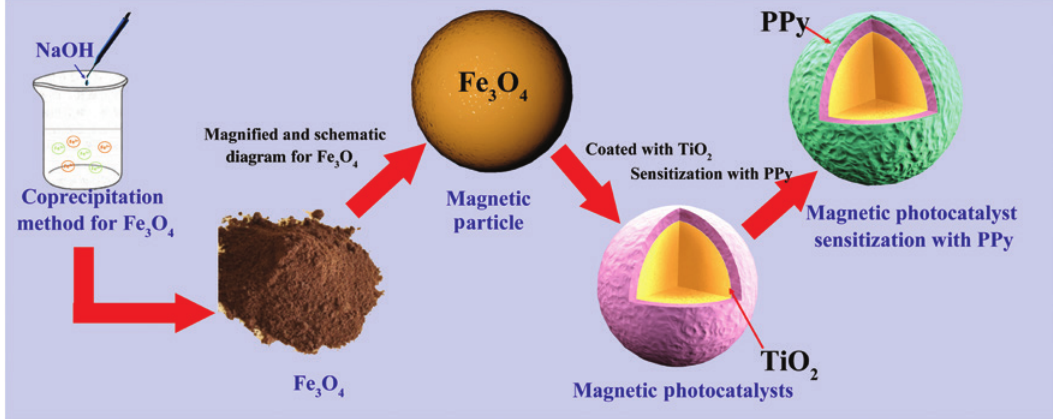
Figure 1 The schematic preparation of a